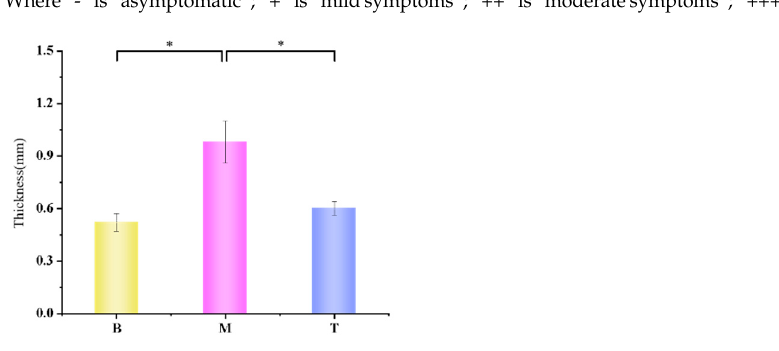
Figure 9. Average skin thickness of mice in each group on the 30th day (* p < 0.05).